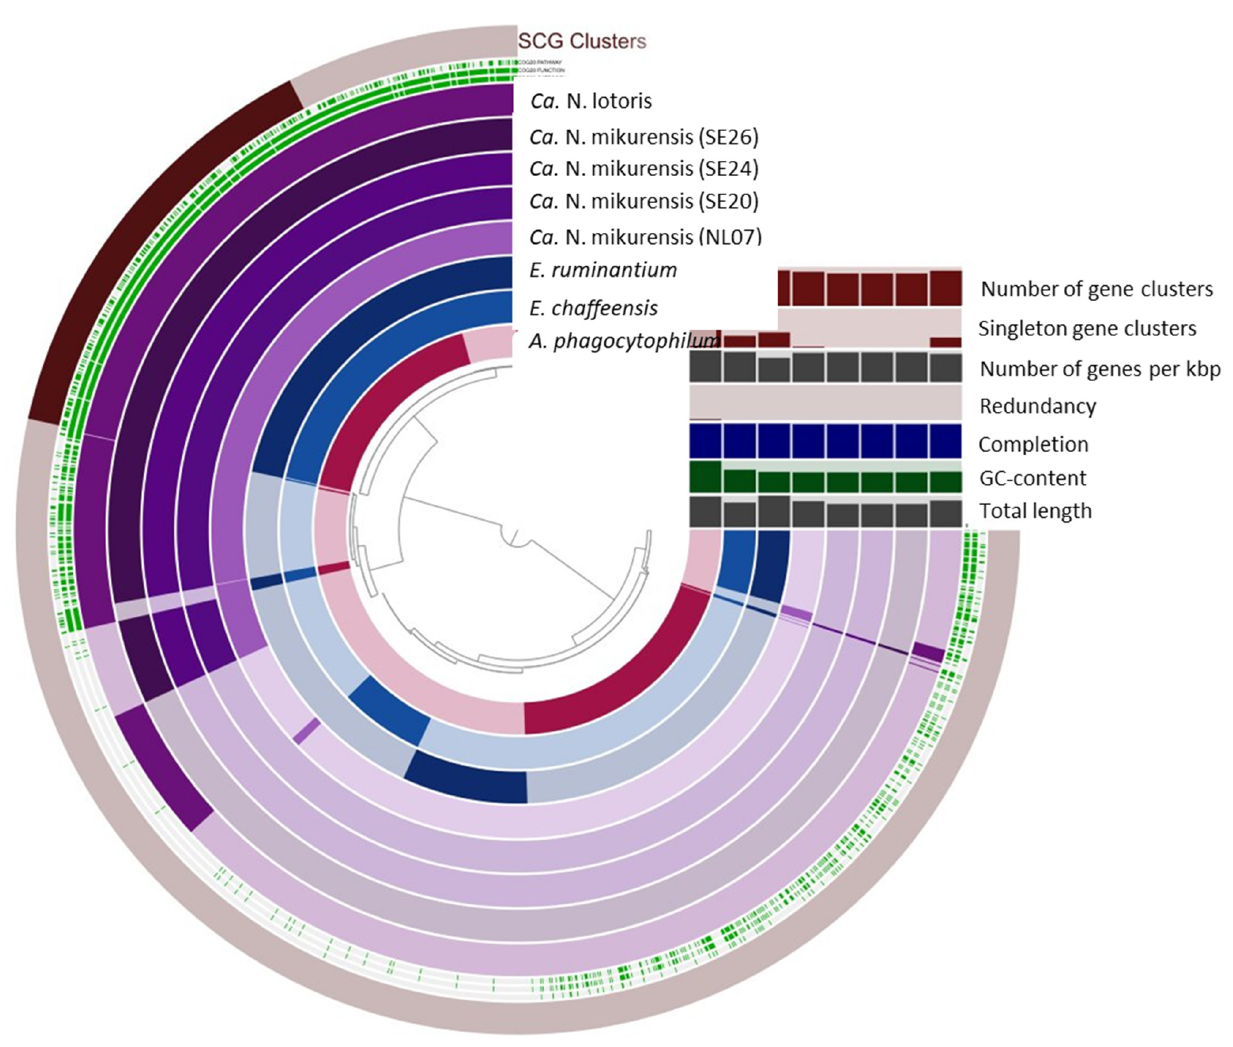
Figure 3. Comparative Anvi’o genomic analysis of NL07 and the additional Ca. N. mikurensis, Ca. N. lotoris, E. chaffeensis , E. ruminantium, and A. phagocytophilum genomes included in this study based on the presence/absence of gene clusters. The inner layers represent individual genomes organized by their phylogenetic relationships as indicated by the dendrogram. In the layers, dark colors indicate the presence of a gene group, and light colors indicate its absence. Number of gene clusters, singleton gene clusters, number of genes per kbp, redundancy, completion, GC content, and total length are represented in bar plots. SCG clusters = Single copy gene clusters.